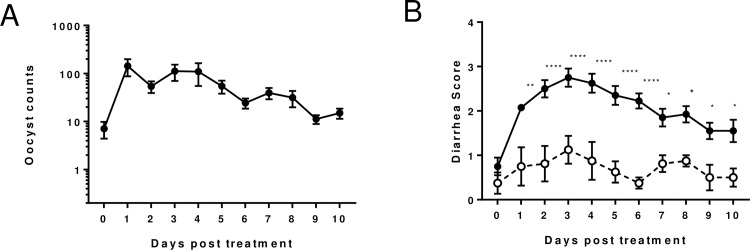
The oocyst excretion pattern, intensity of diarrhea and body weight gains of the GB piglets orally challenged with TU502 oocysts.(A) Daily oocyst shedding (means ± SEM) in feces. The rectal swabs were processed and counted in 30 microscopic fields under 1,000x magnificent. (B) Daily diarrhea scores (means ± SEM) observed in piglets. Symptoms were monitored and scored daily by 2 individuals; diarrhea was scored from 0 to 4 (0 –no diarrhea; 1 –brown, grey, soft stool, mild diarrhea; 2 –brown yellow, mucoid, mild to moderate diarrhea; 3 –yellow, mucoid to watery, moderate diarrhea; 4 –white to yellow, watery, severe diarrhea). Two-way ANOVA with Sidak's multiple comparisons test was performed using GraphPad Prism 7.01. *p<0.05, **p<0.01, ****p<0.0001. TU502-infected group (n = 10, closed circle ●); Uninfected control (n = 4, open circle ○). Loose feces in uninfected animals, attributed to the milk diet, are often observed.